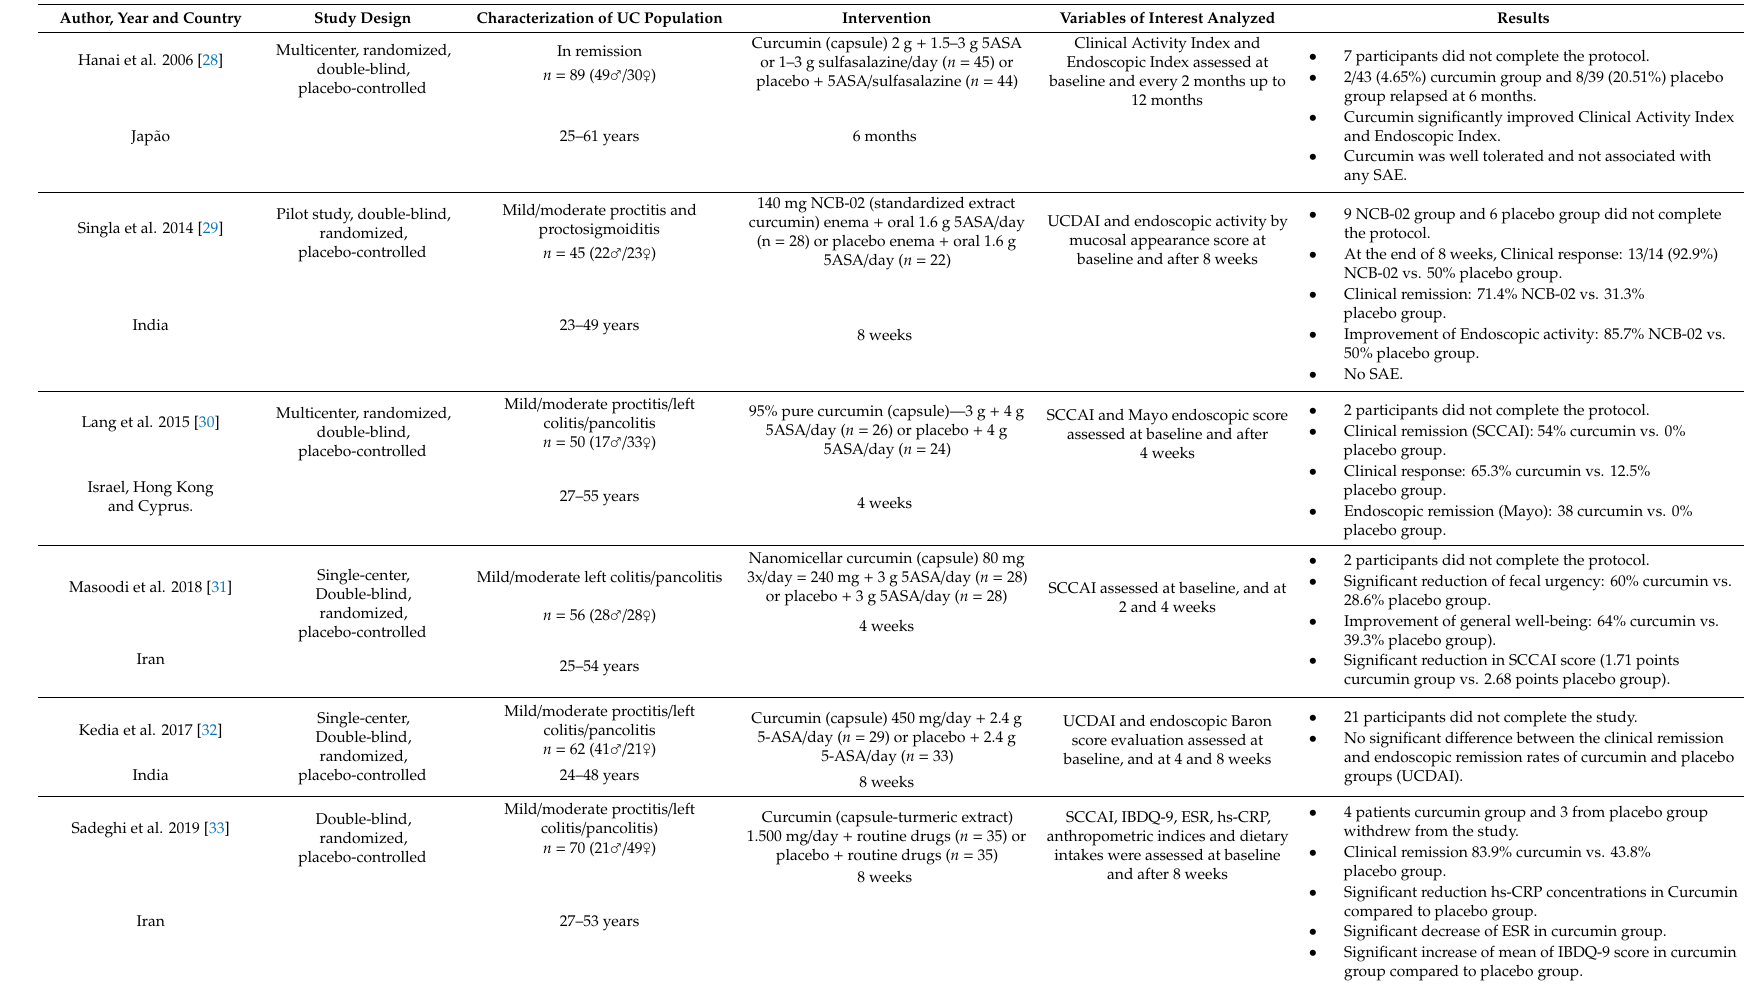
Table 2. Summary of studies included in the systematic